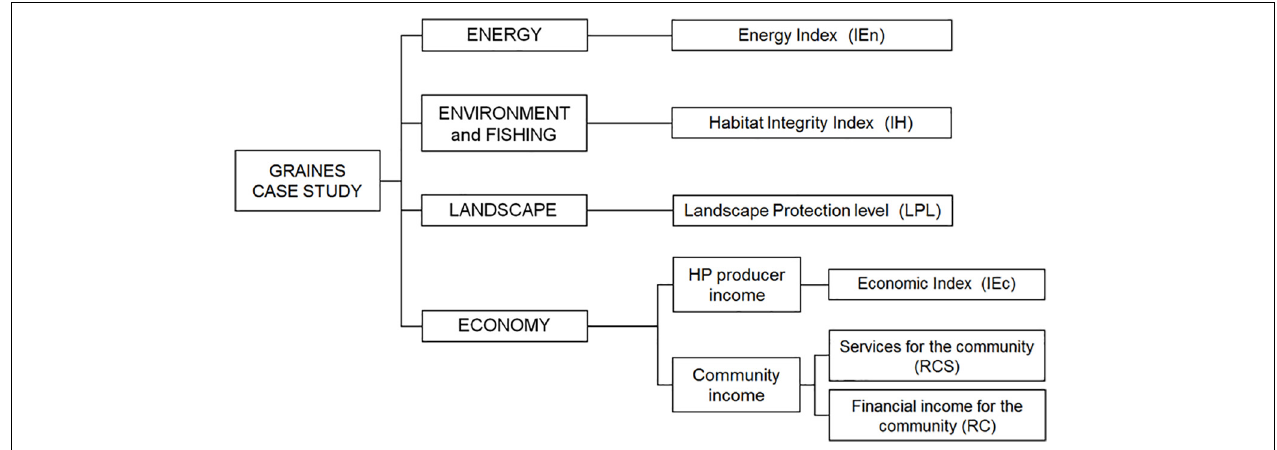
FIGURE 2 | Decision tree of the case study: one or more indicators (on the right) are associated with each of the four considered criteria (in capital letters). Criteria and indicators represent the “branches” and the “leaves,” respectively, of the decision tree.